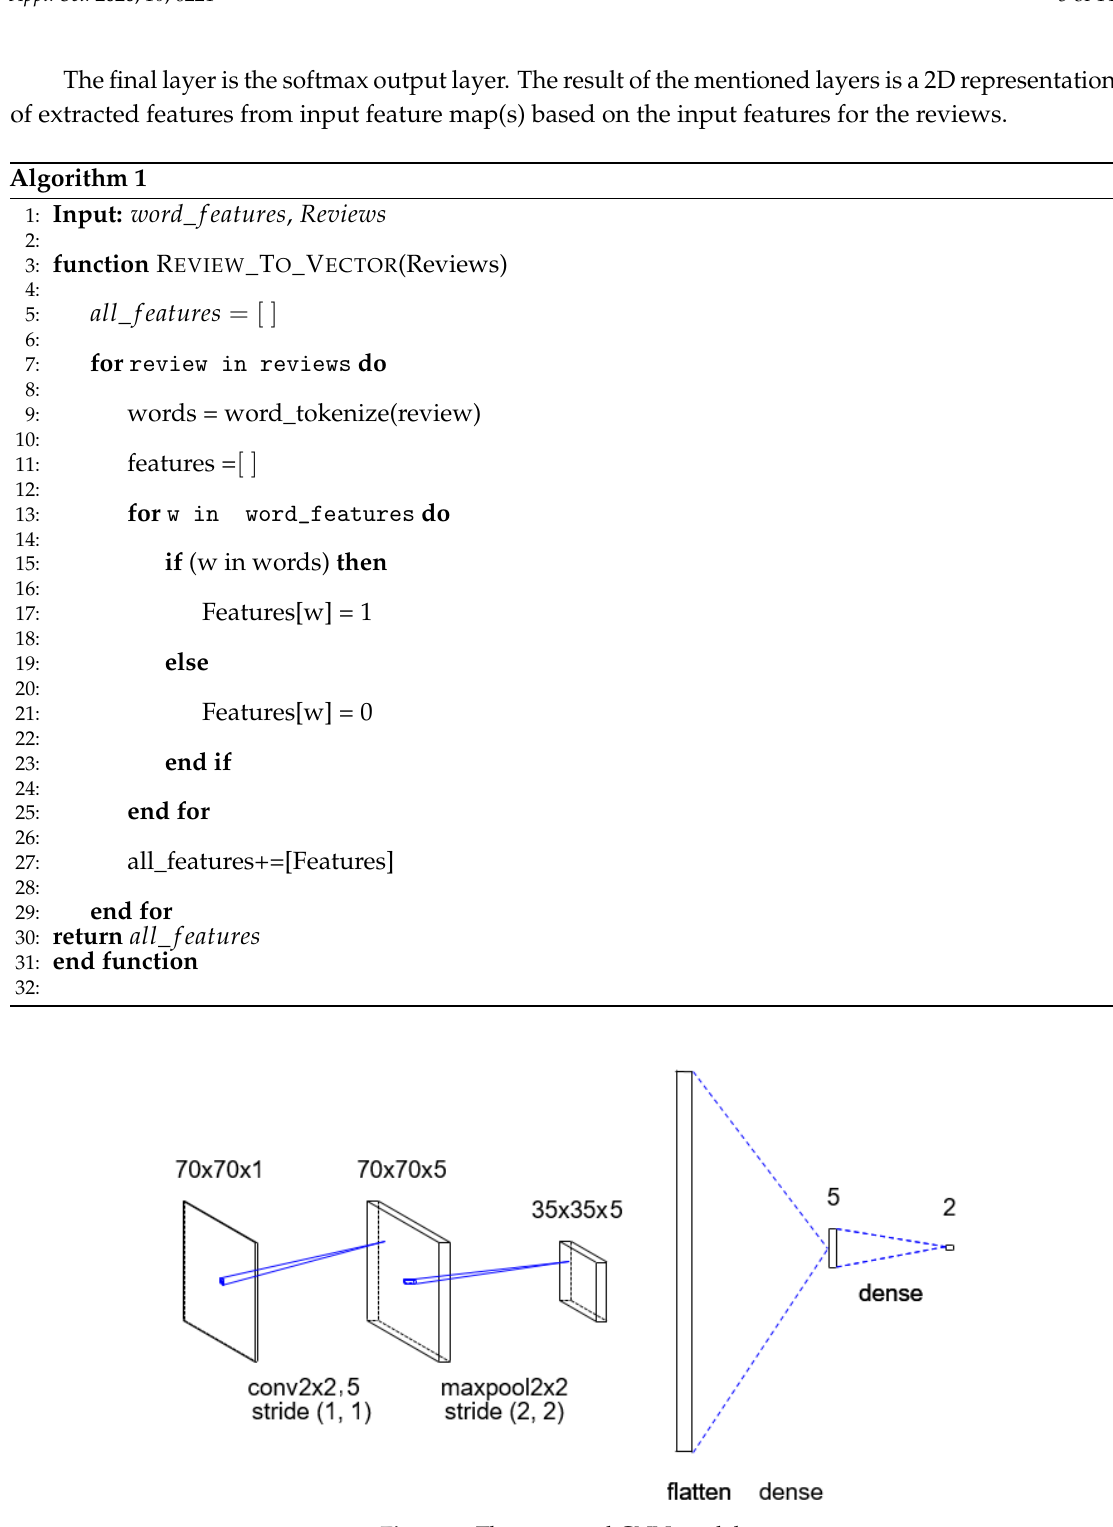
Figure 1. The proposed CNN